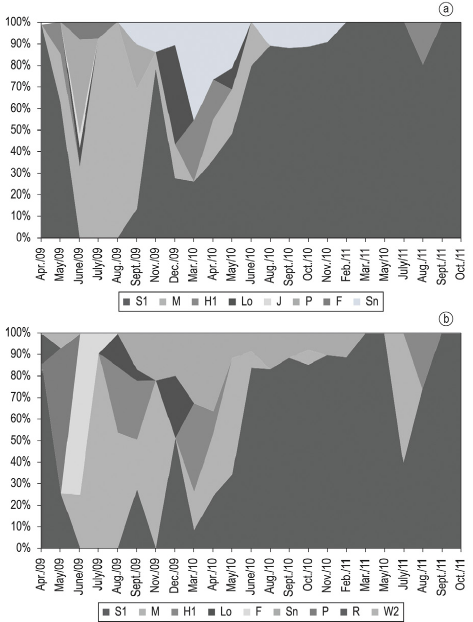
Figure 5. Relative contribution (%) of functional groups at Armando Ribeiro Gonçalves Reservoir in a) P1 and b) P2 of April 2009 to